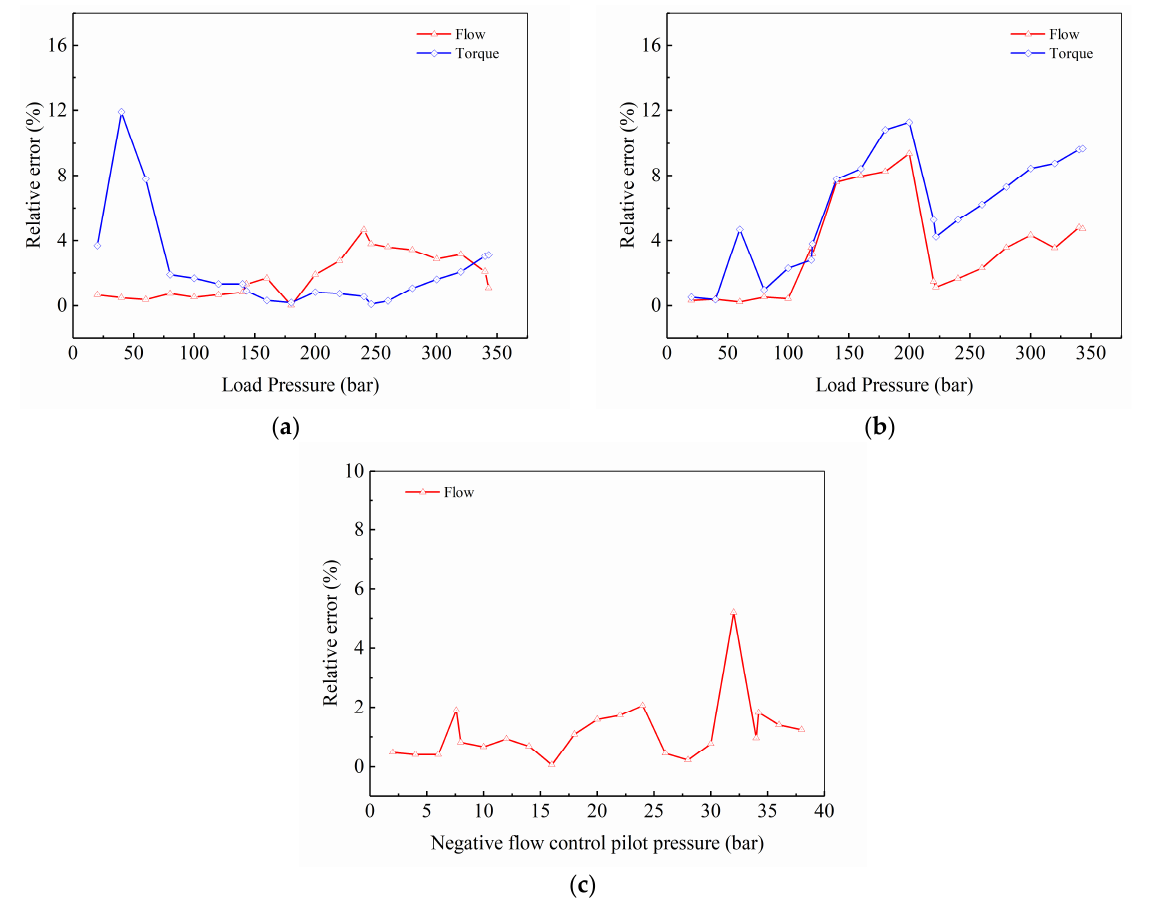
Figure 15. Error between experimental results and simulation results: ( a ) condition 1; ( b ) condition 2; ( c ) condition 3.